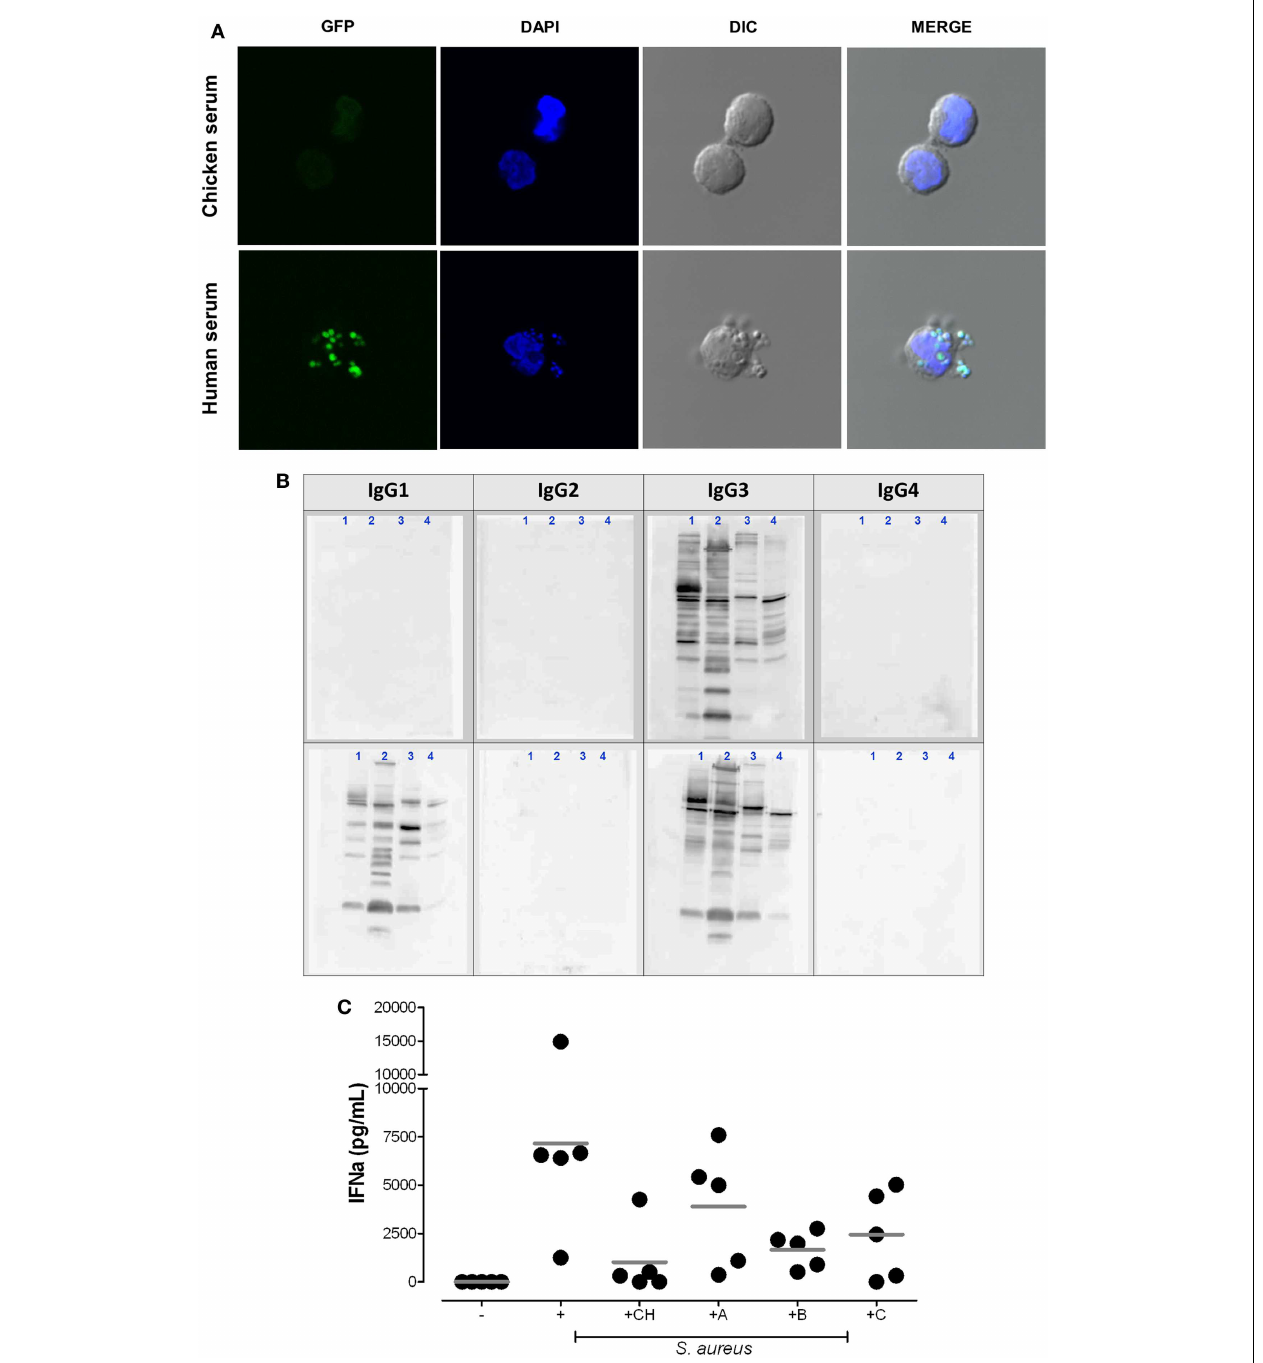
protein lysates from USA300 (1), Newman (2),Wood46 (3), and SA113 ∆ spa (4) were loaded on SDS-PAGE.Western blot analysis visualizes the IgG subclasses present in serum from patient 1 (IgG 3 only) and patient 2 (IgG 1 and IgG 3 only, selective IgG 2/4 -deficiency). Membranes were incubated with serum followed by biotinylated anti-human IgG subclass antibodies and streptavidin-HRP as described in Ref. (7). (C) pDC medium was supplemented with 5% chicken serum (CH), autologous serum [healthy adult donor (A) ], or serum from patient 1 (B) or patient 2 (C) . IFN- α release from pDC was quantified in the supernatants after 24h stimulation.The graph summarizes the results obtained in five experiments with independent pDC